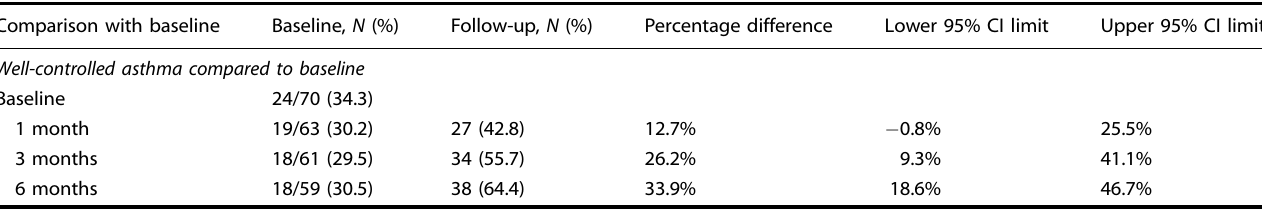
Table 4. Percentage differences on well-controlled asthma over time.